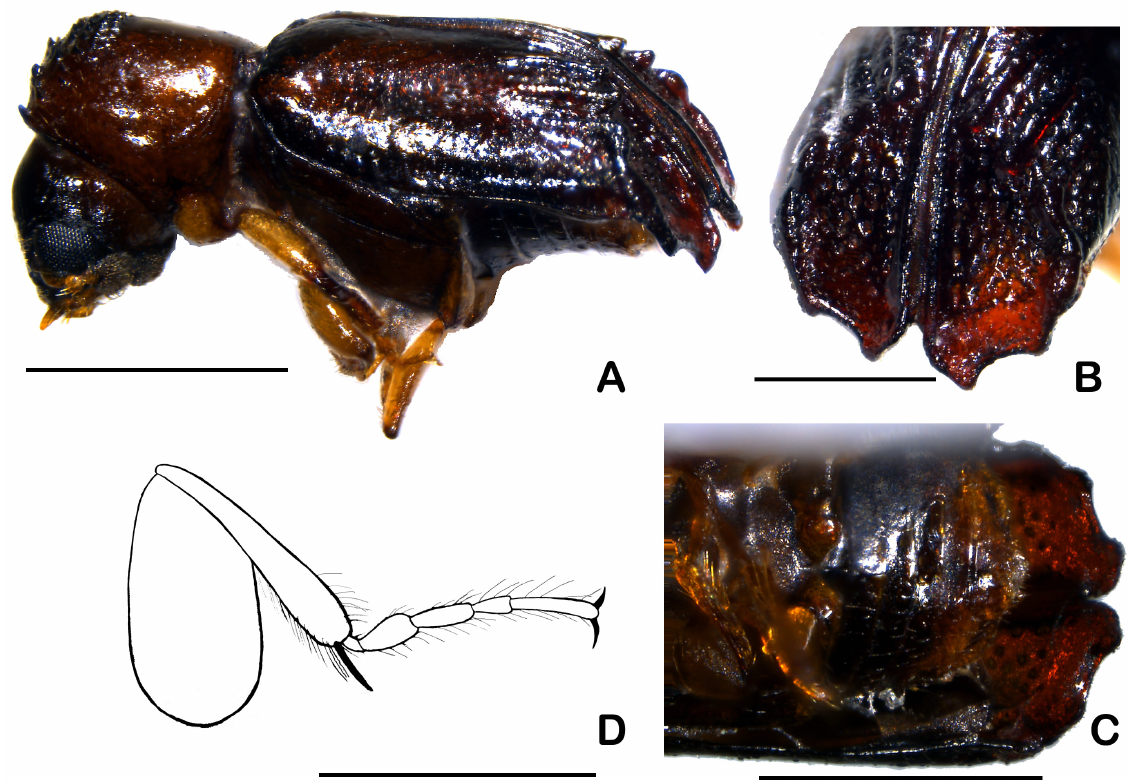
Fig. 3. Octomeristes pusillus Liu & Beaver, gen. et sp. nov., paratype, ♂ (KSU). A . Lateral view. B . Postero-lateral view of elytral declivity. C . ventral view of abdomen. D . Proleg showing short, straight hairs on tarsi. Scale bars: A = 1 mm; B–D = 0.5